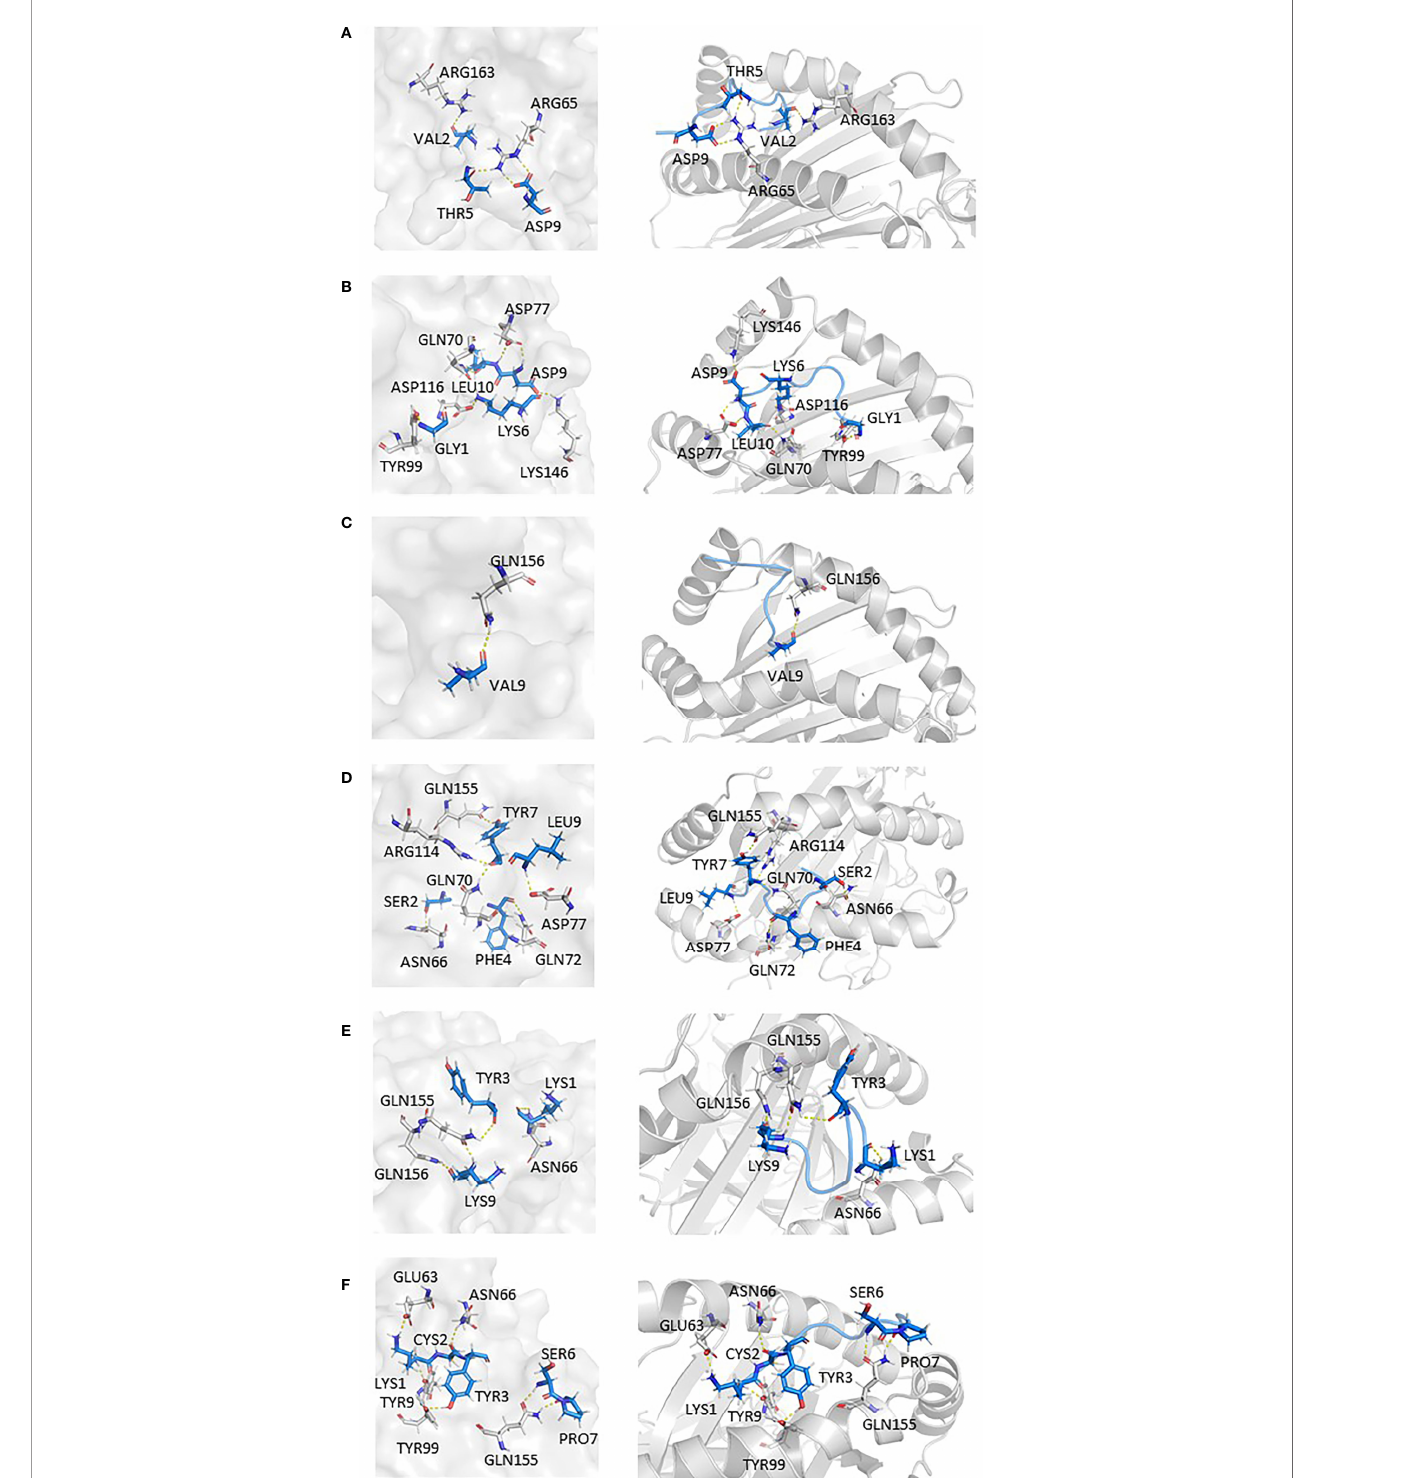
FIGURE 6 | Epitopes obtained from V382L interaction with HLA-A*11:01; epitopes are shown in marine, HLA structure is shown in gray. (A) HLA-A*11:01(5GRD)- GVSPTKLNDL (WT). (B) HLA-A*11:01(5GRD)-GLSPTKLNDL (MT). (C) HLA-A*11:01(5GRD)-FSTFKCYGV (WT). (D) HLA-A*11:01(5GRD)-FSTFKCYGL (MT). (E) HLA-A*11:01(1X7Q)-KCYGVSPTK (WT) (F) HLA-A*11:01(1X7Q)-KCYGLSPTK